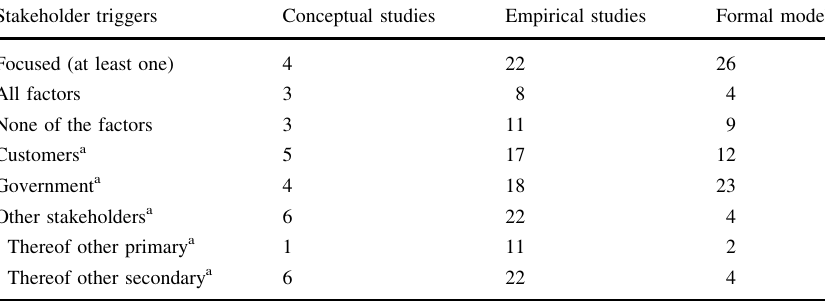
Table 12 Stakeholder triggers for SSCM Stakeholder triggers